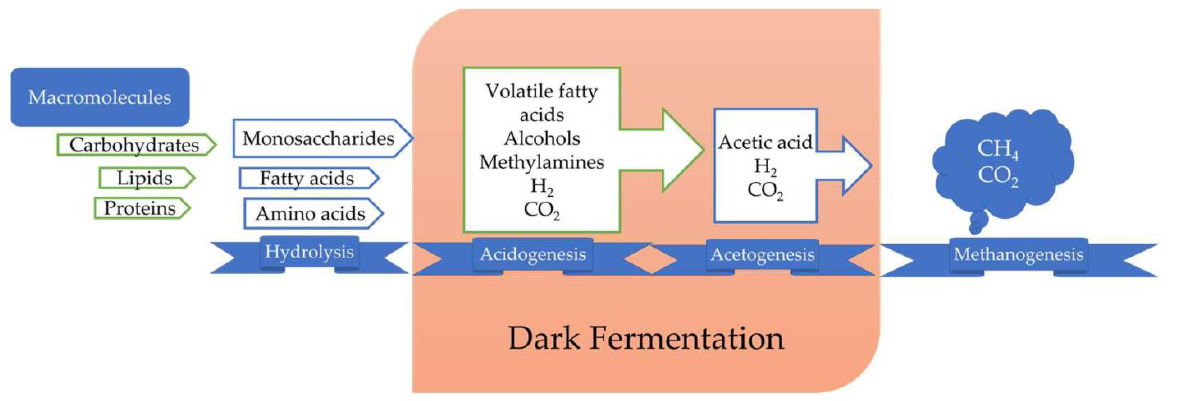
Figure 5. Dark fermentation integrated within the anaerobic digestion process.